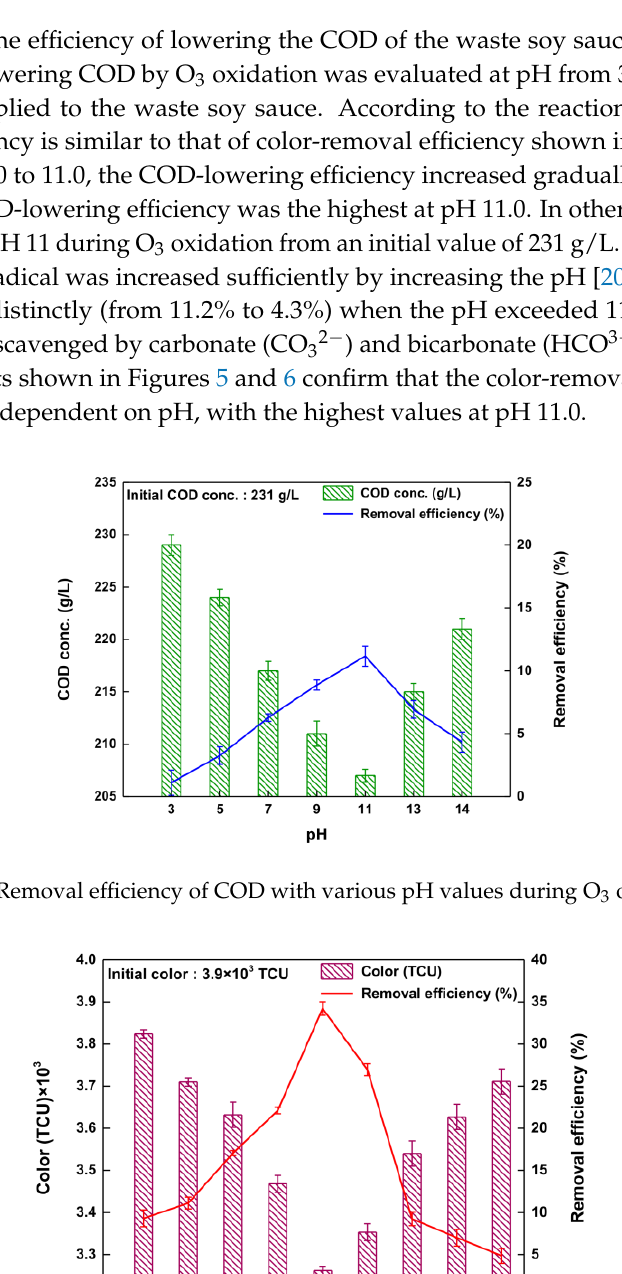
Figure 5. Removal efficiency of COD with various pH values during O 3 oxidation.